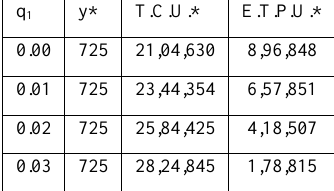
Table 4. Impact of q 1 on optimal production policy